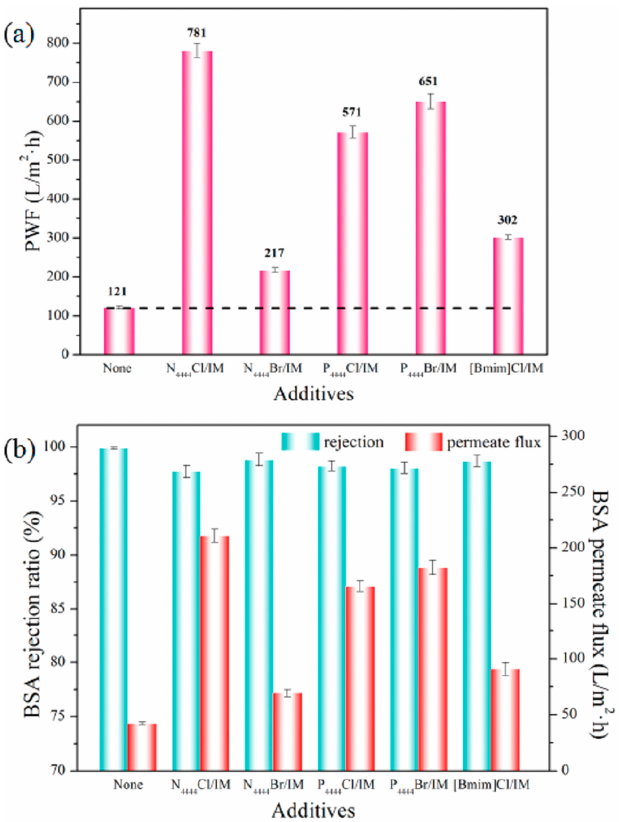
Figure 15. ( a ) Pure water flux and ( b ) BSA rejection and permeate flux of PES membranes with different IM-based DESs as additives. Transmembrane pressure: 2 bar [75].